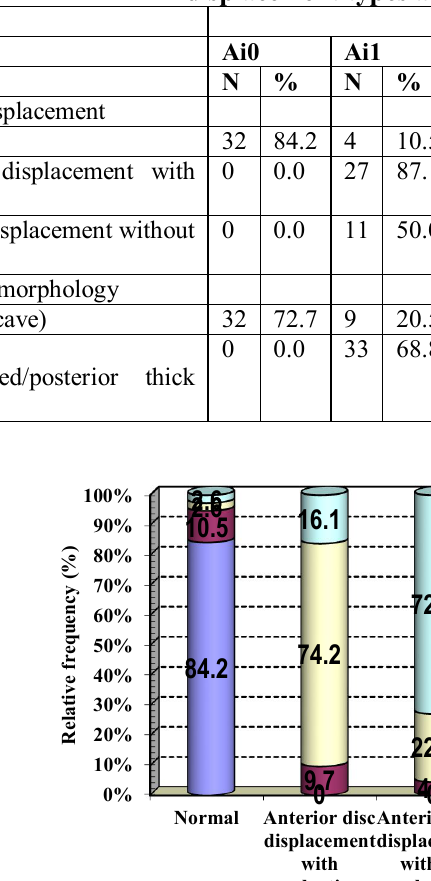
Table 1: Correlation between Helkimo anamnestic index and MRI findings of TMJ disc displacement types and disc morphology.